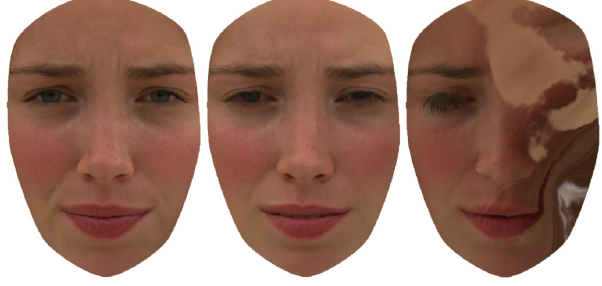
Fig. 13 Unwrapped samples of the wife sequence (100, 50, and 1).